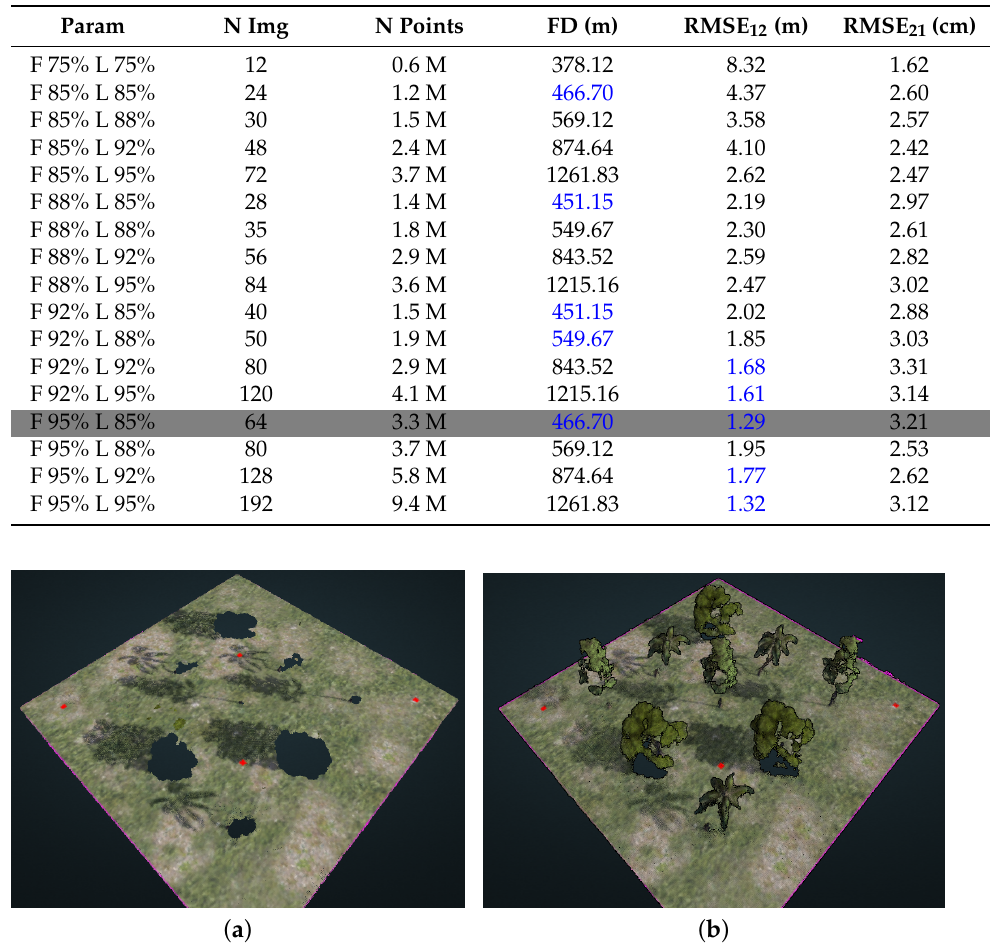
Figure 7. Comparison between two reconstructions belonging to two different overlap flights (highest and lowest values of Table 1). Although in Table 1 the lowest value of RMSE 21 is for the case F75%L75%, the reconstruction is lacking a large number of point in the trees. This example shows that RMSE 21 is a good indicator of the points precision but is not good to evaluate the quality of the reconstructed cloud. ( a ) Reconstrution: F75% L75%. ( b ) Reconstrution: F95%